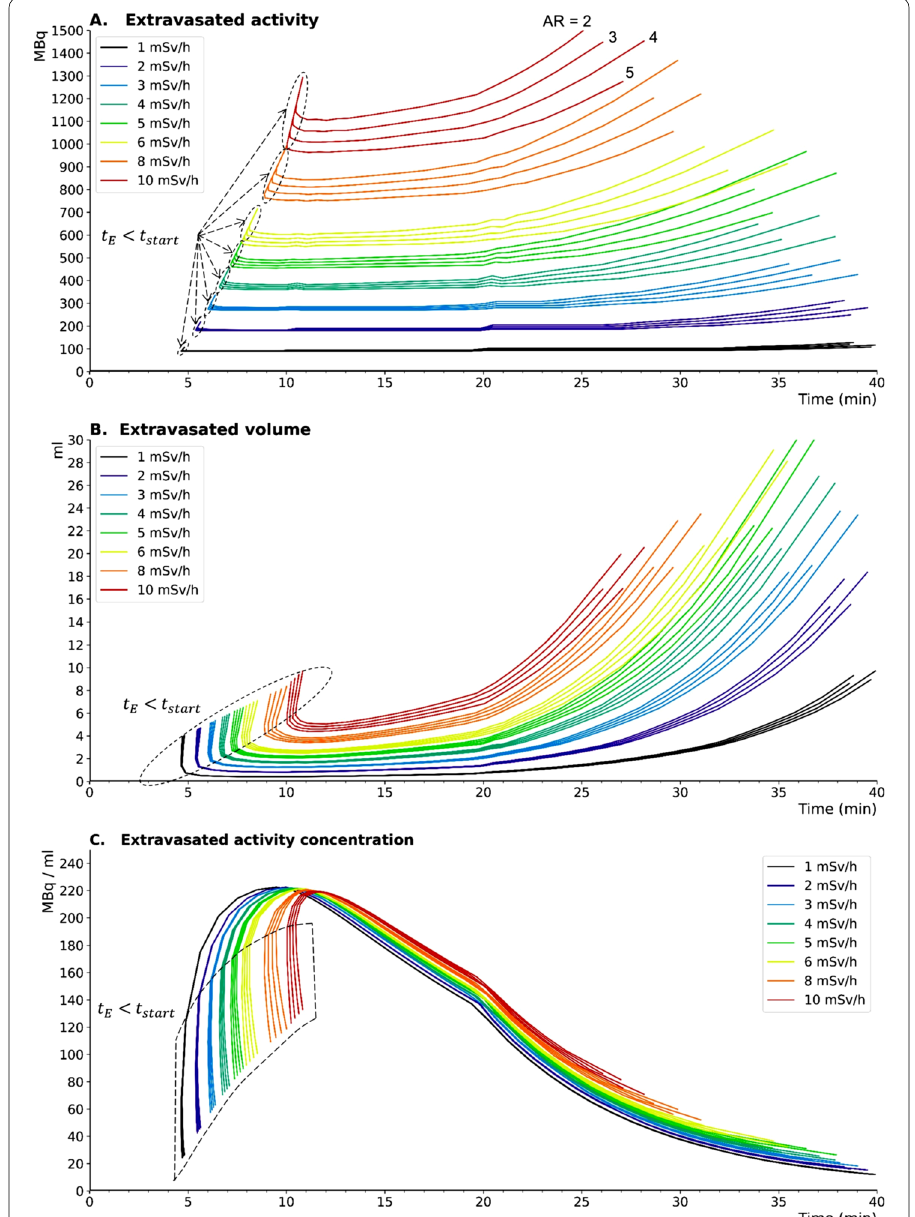
Fig. 8 Range of extravasated activity ( A ), volume ( B ), and activity concentration ( C ) versus time for 4 aspect ratios (AR 2, 3, 4, 5) that leads to the same EDR and for 8 representative EDR values (1, 2, 3, 4, 5, 6, 8 and = 10